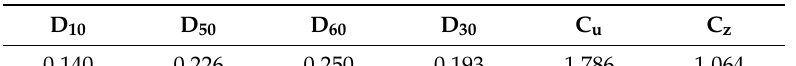
Figure 6. Particle size distribution of F60 sand. Figure 5. Particle size distribution of F60 sand. Table 6. Sand Table 5. Sand parameters.